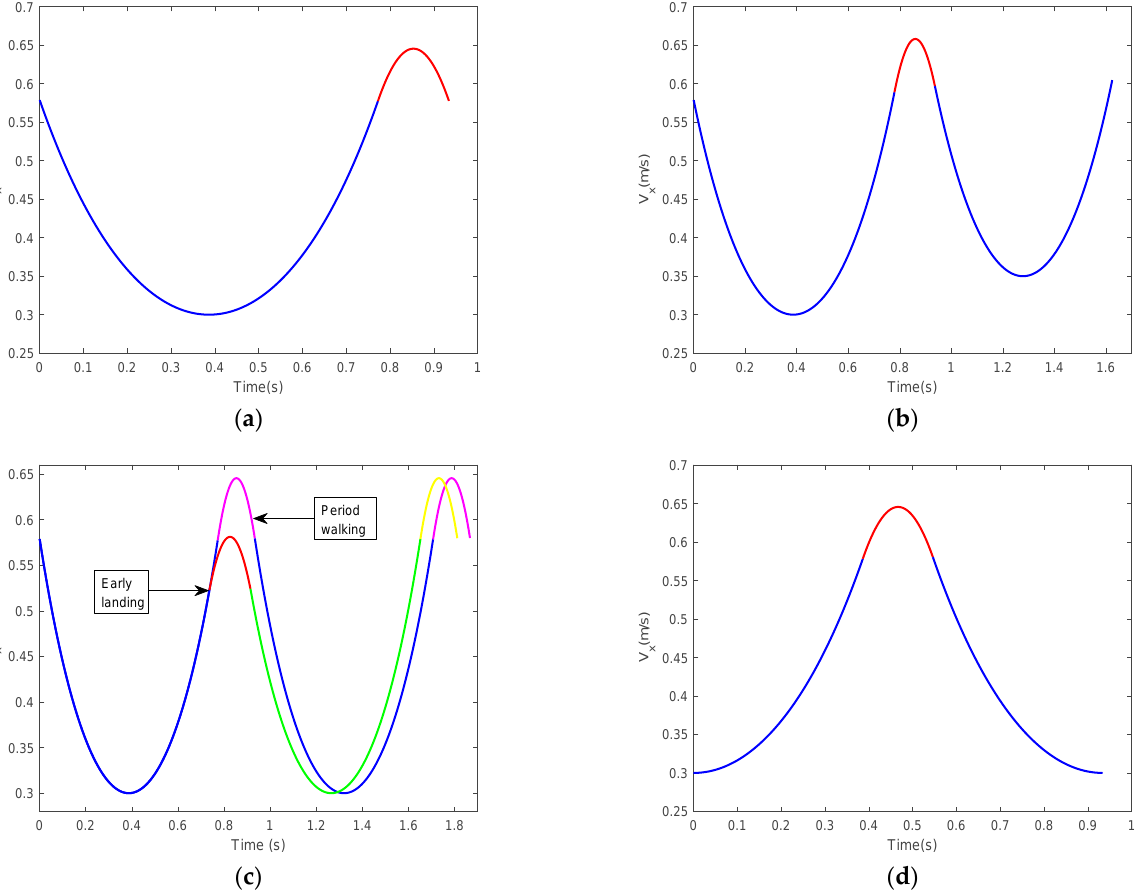
Figure 10. CoM velocities in X-direction under different conditions: ( a ) CoM velocity for period walking; ( b ) CoM velocity for adjusting walking speed with fixed step-length; ( c ) CoM velocity for unexpected landing time or foot placement; ( d ) CoM velocity walking on uneven ground.